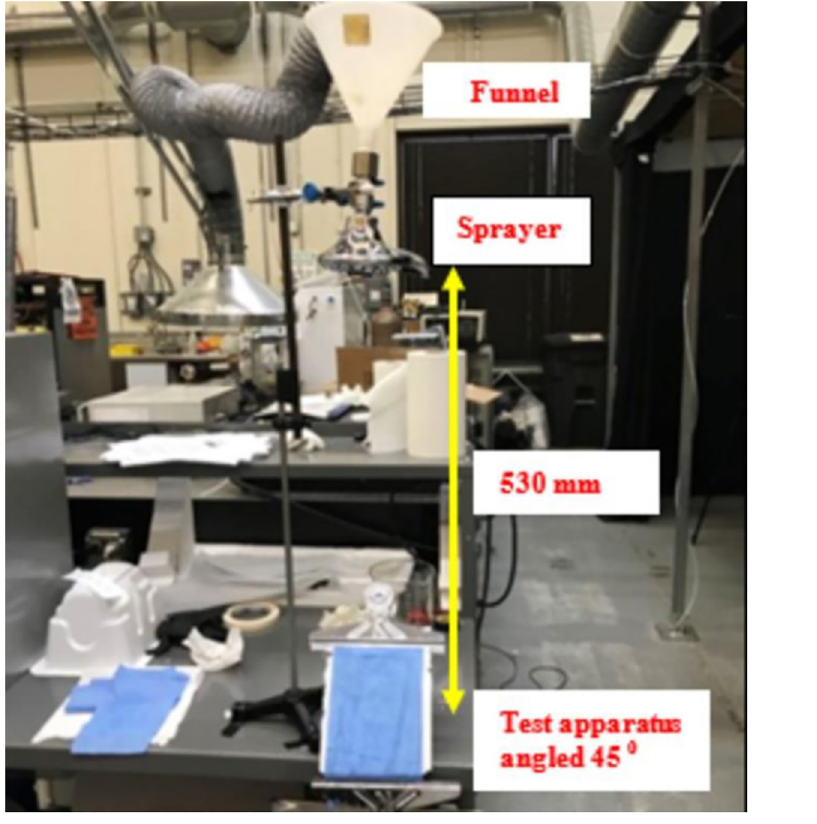
Fig 12. Schematic of the water impact penetration testing